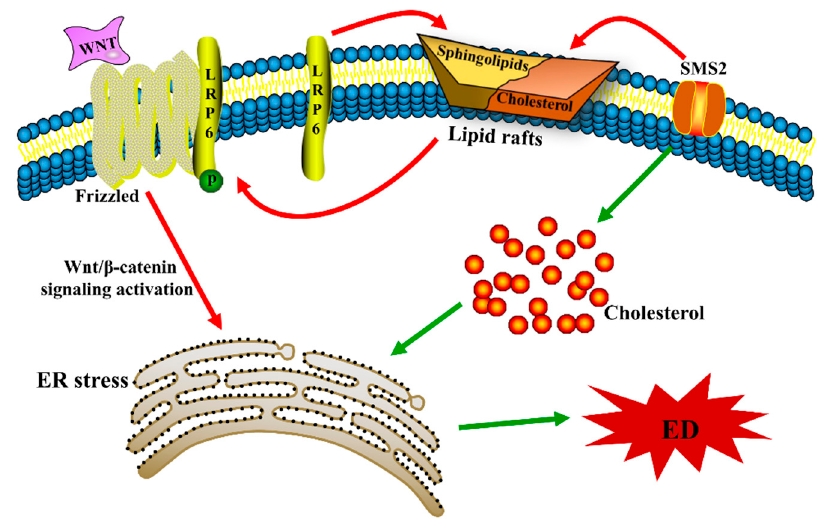
Figure 7. The possible mechanism by which endoplasmic reticulum stress is induced by SMS2. ER stress, endoplasmic reticulum stress; ED, endothelial dysfunction.